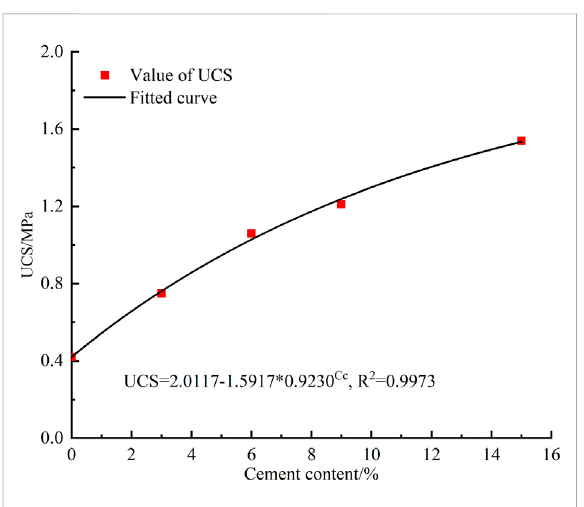
FIGURE 7 Uncon fi ned compressive strength vs. cement